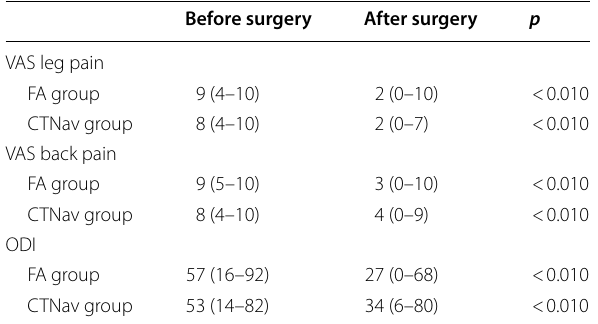
Data are expressed as median (range). VAS visual analog scale, ODI Oswestry disability index, FA fluoroscopy assisted, CTNav CT-navigation assisted